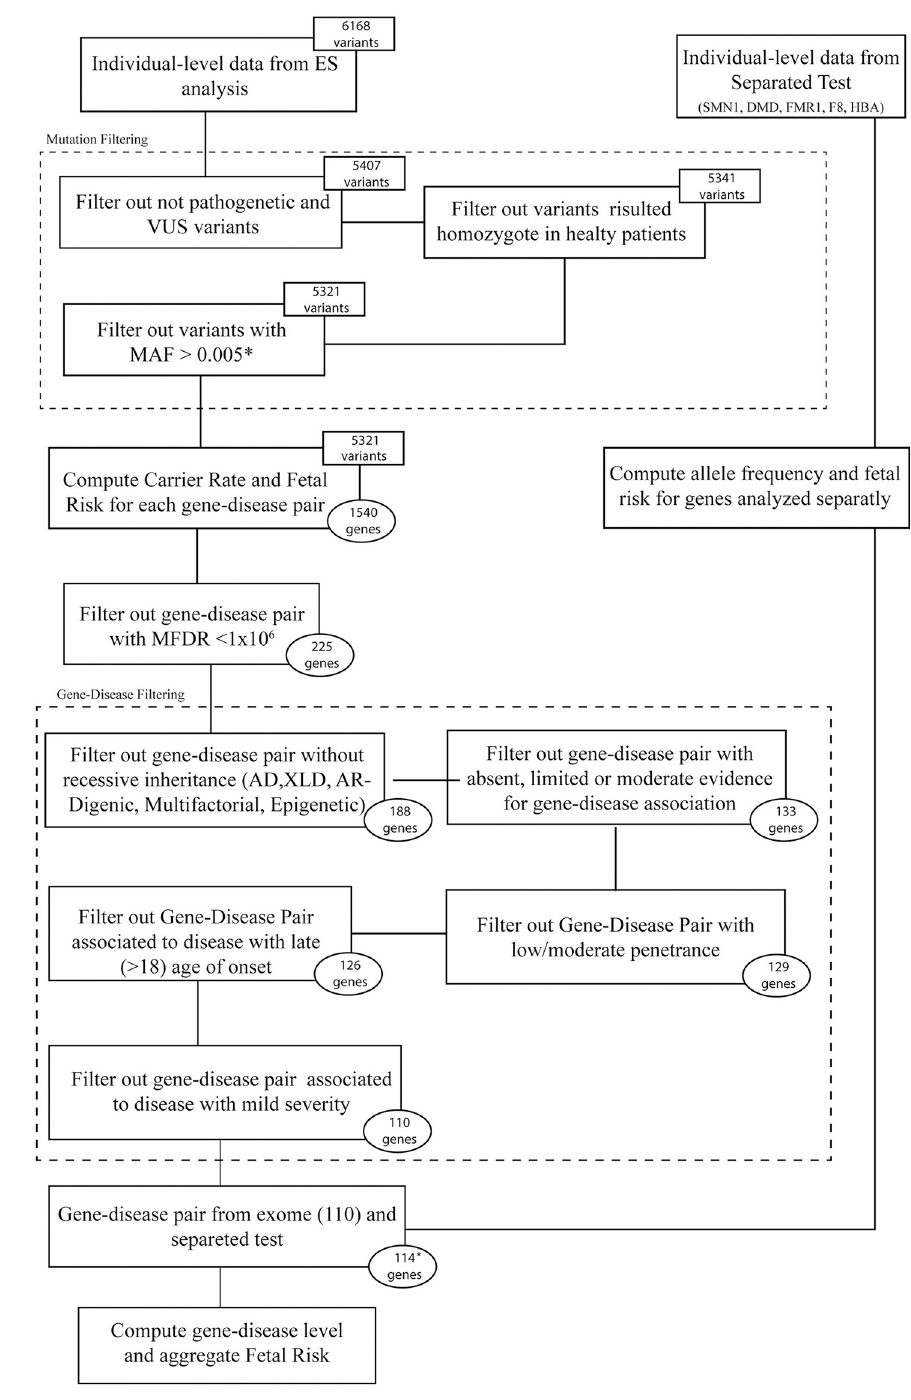
Fig 1. Variant and gene-disease pair selection